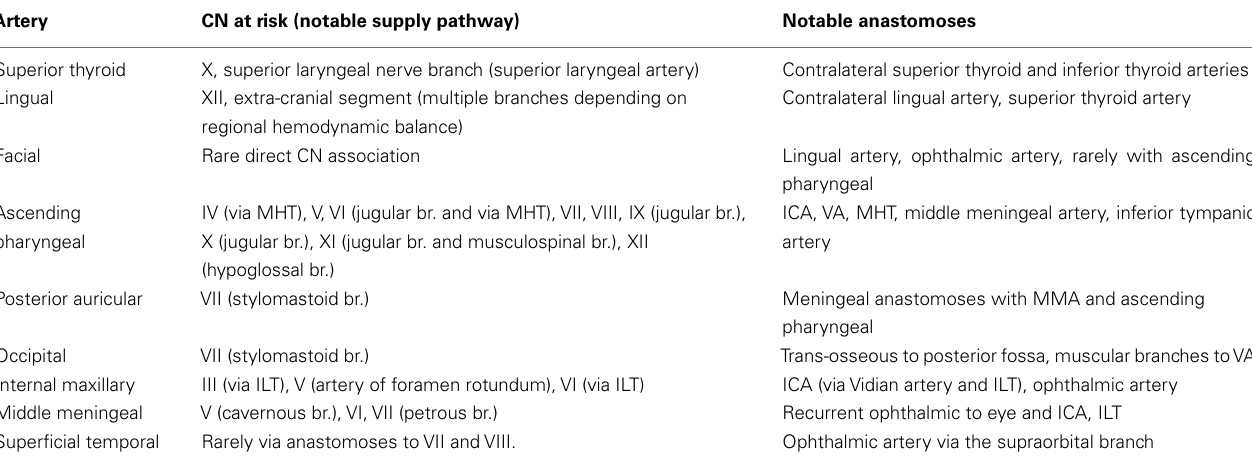
Table 1 | External carotid arteries, associated cranial nerves, and notable anastomoses.